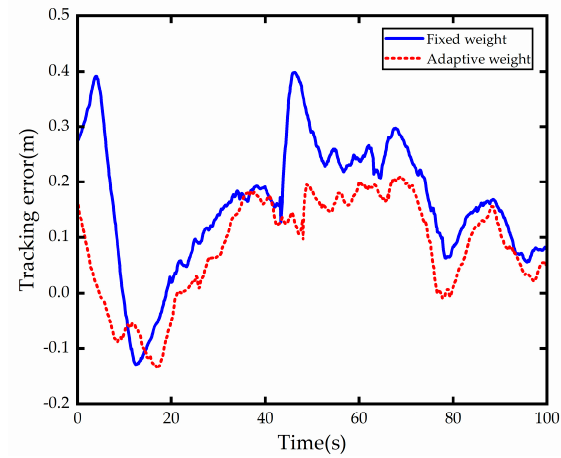
Figure 16. Steering wheel angle comparison.